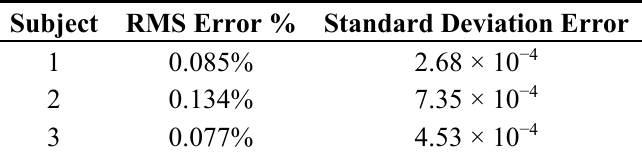
Table 2. Results of RMS Error percentage and SD Error for the calculation of θ S